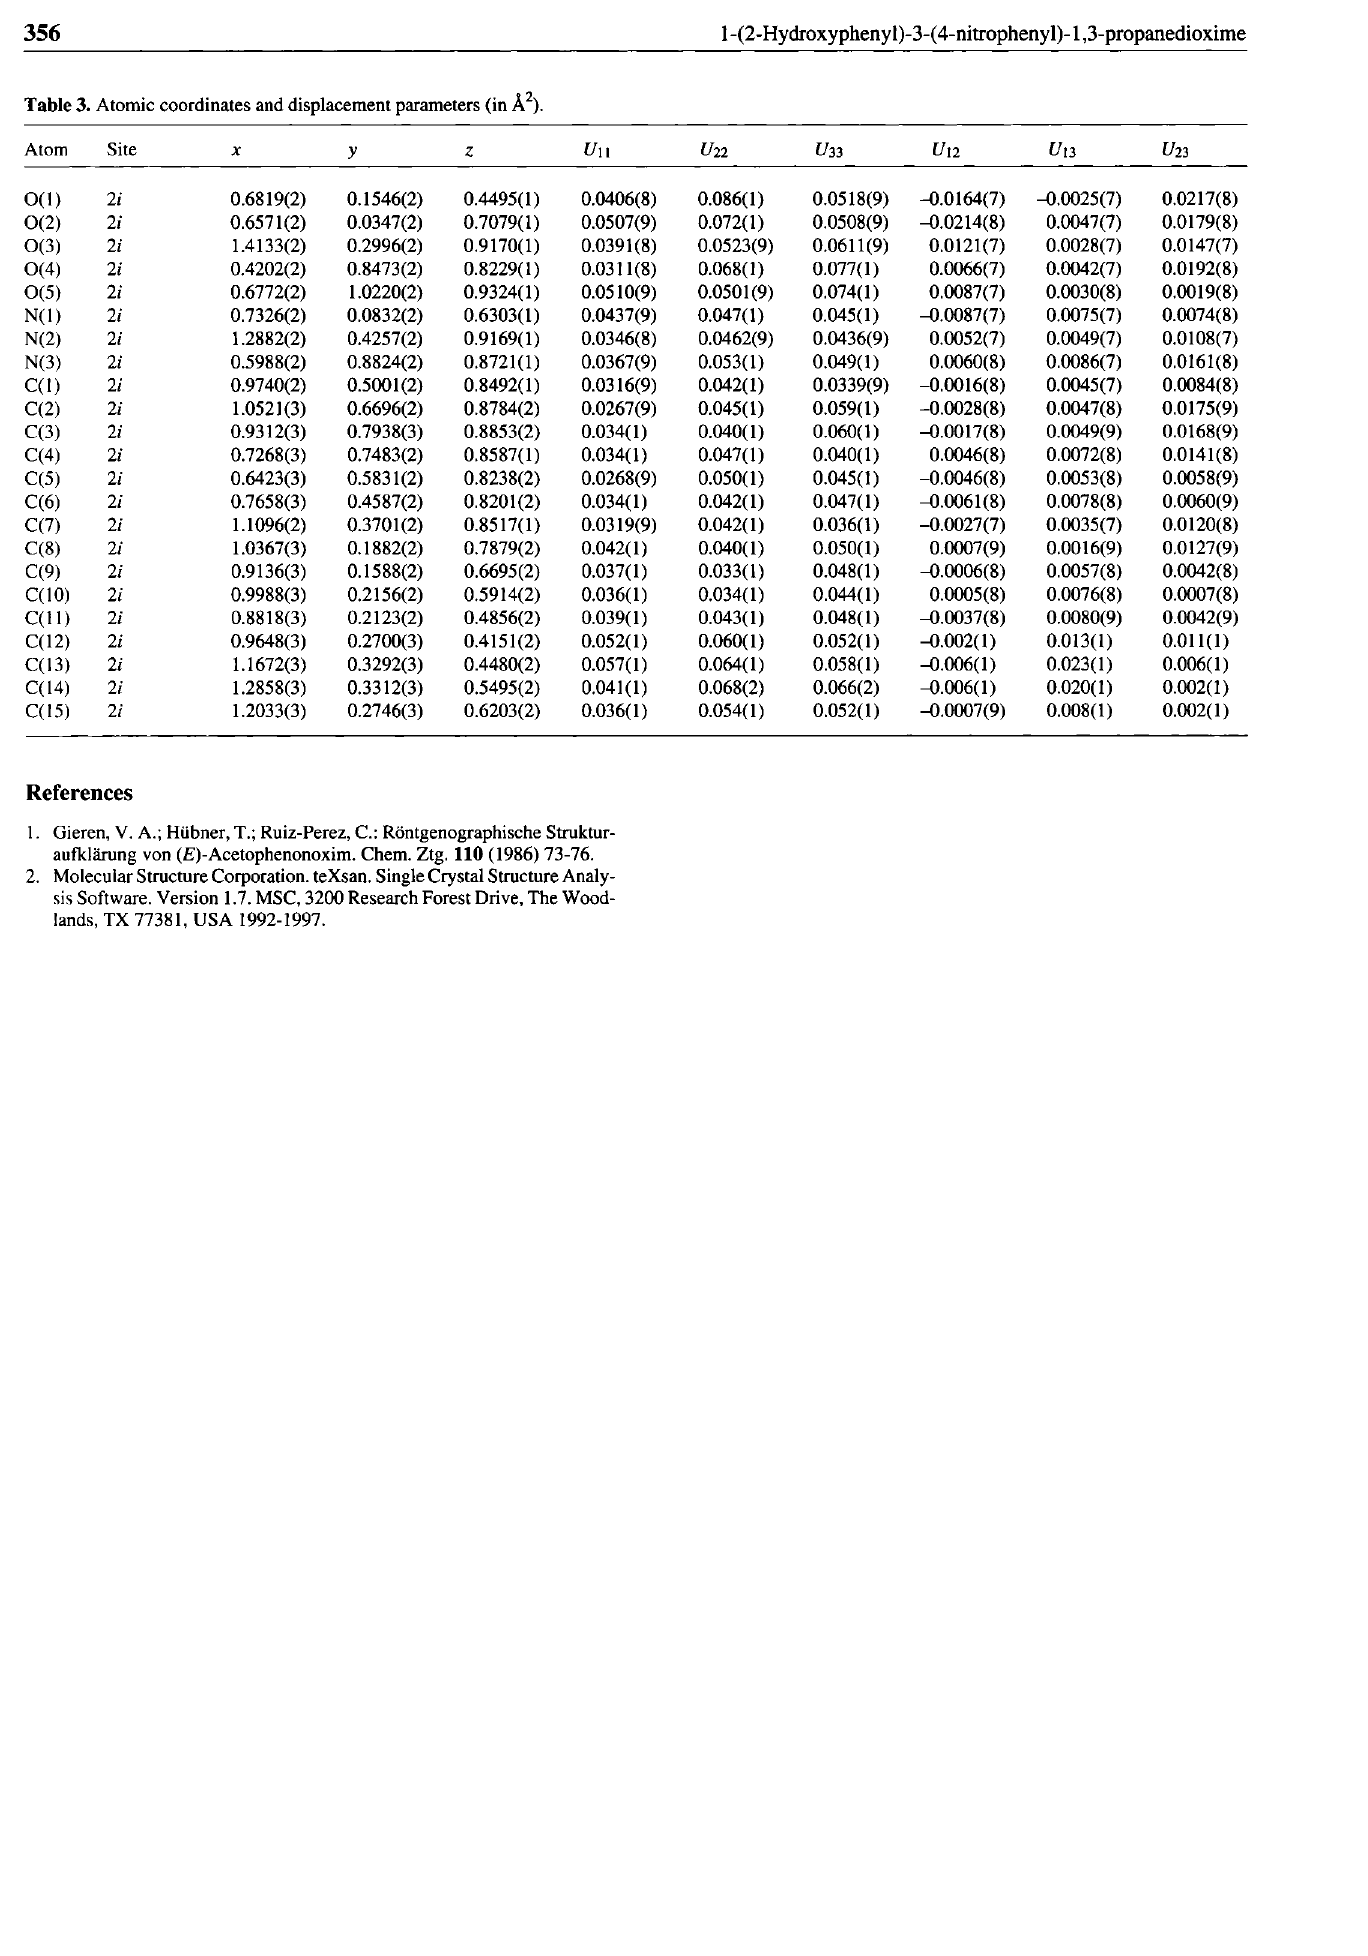
Table 3. Atomic coordinates and displacement parameters (in A 2